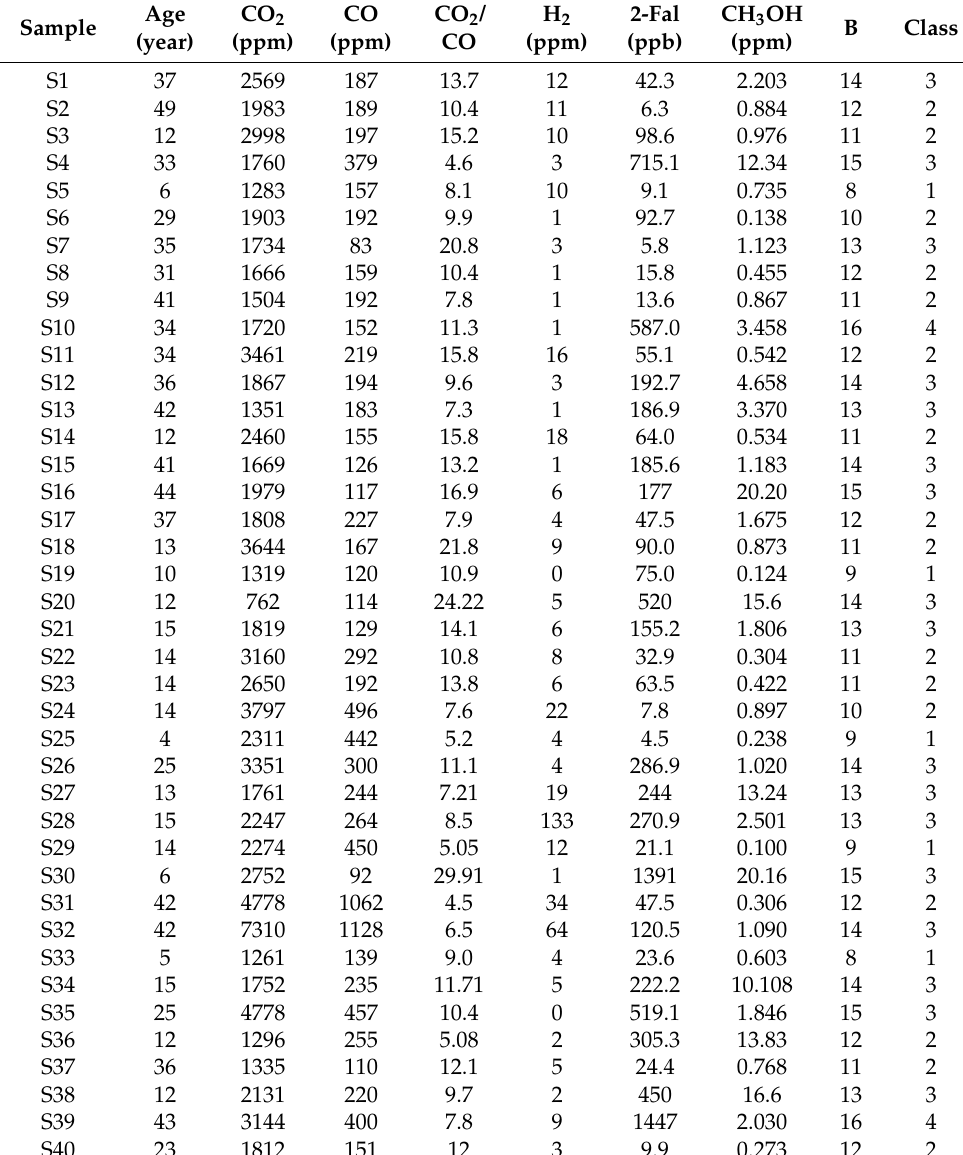
Table 3. Results of measurements and classification of the